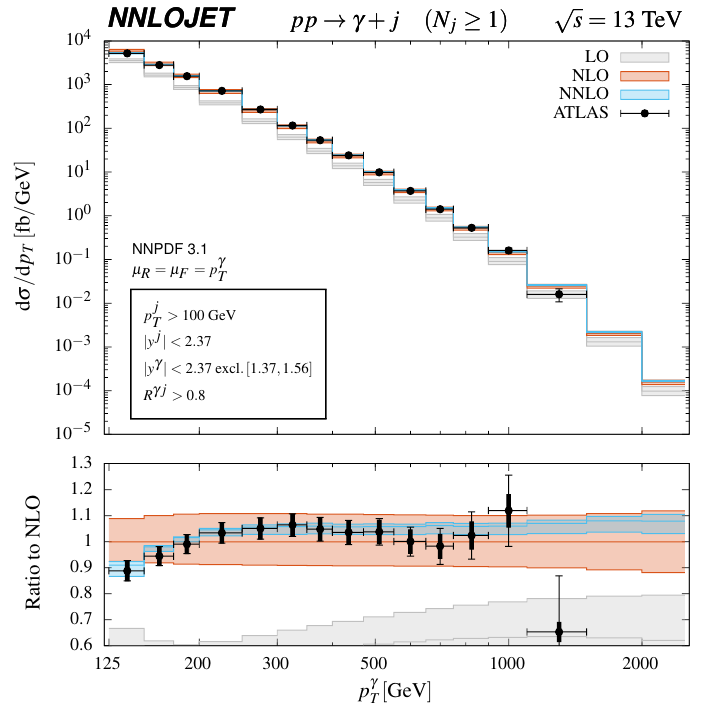
Figure 11 . Transverse momentum distribution of the photon in photon-plus-jet events, at LO, NLO and NNLO. The predictions are compared to ATLAS data